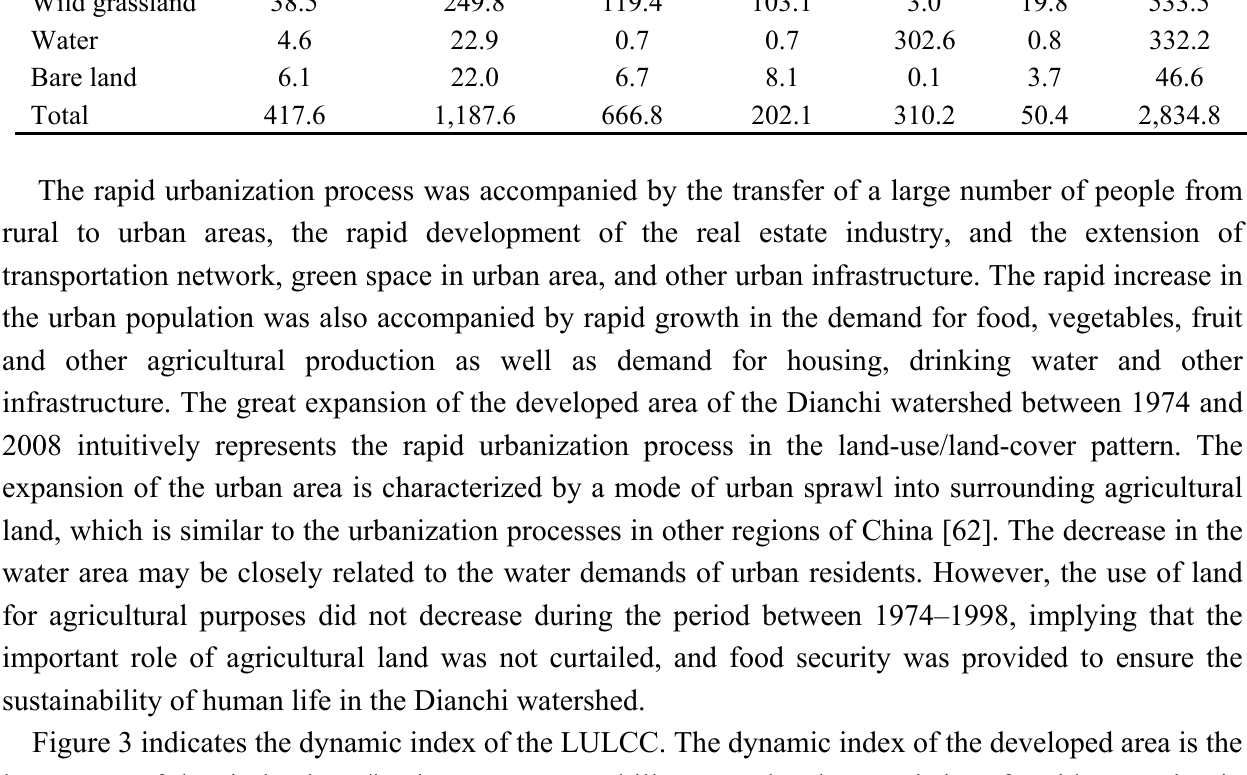
Table 4. Transition matrix of land-use/land-cover types from 1974 to 2008 (Unit: km 2 ). 1974/2008 Developed area Agricultural land Forest land Wild grassland Water Bare